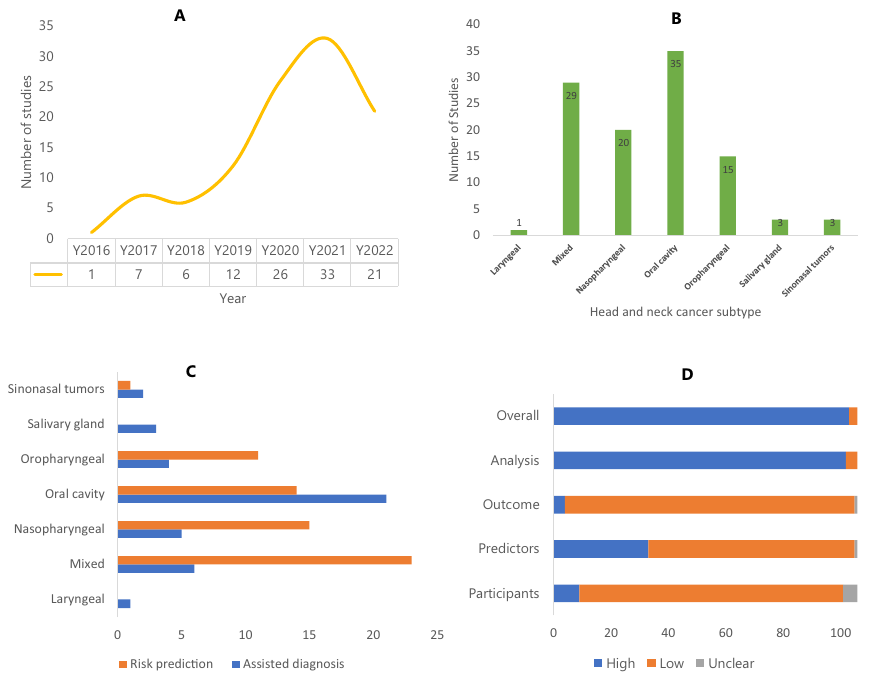
Fig. 2 General characteristics and risk of bias rating for ML studies employing structured datasets. a Publication year trend. b Plot showing the number of patient datasets by the different head and neck cancer subtypes. c Plot showing the clinical utility of the models according to the different cancer subtypes. d Risk of bias rating for individual domains of the PROBAST